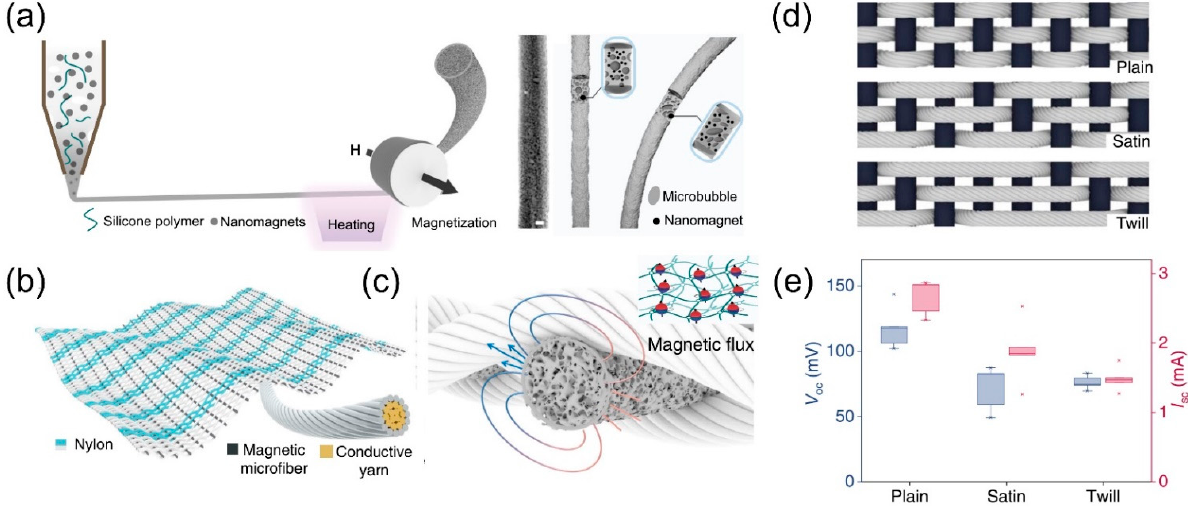
Figure 16. ( a ) Schematics of the soft magnetic fibers created by extrusion via an adjustable nozzle; schematic of the ( b ) design and ( c ) working mechanism of textile magnetoelastic generator; ( d ) schematics showing three different weaving patterns; and ( e ) the corresponding measured electri- cal signals of the textile magnetoelastic generator [136].